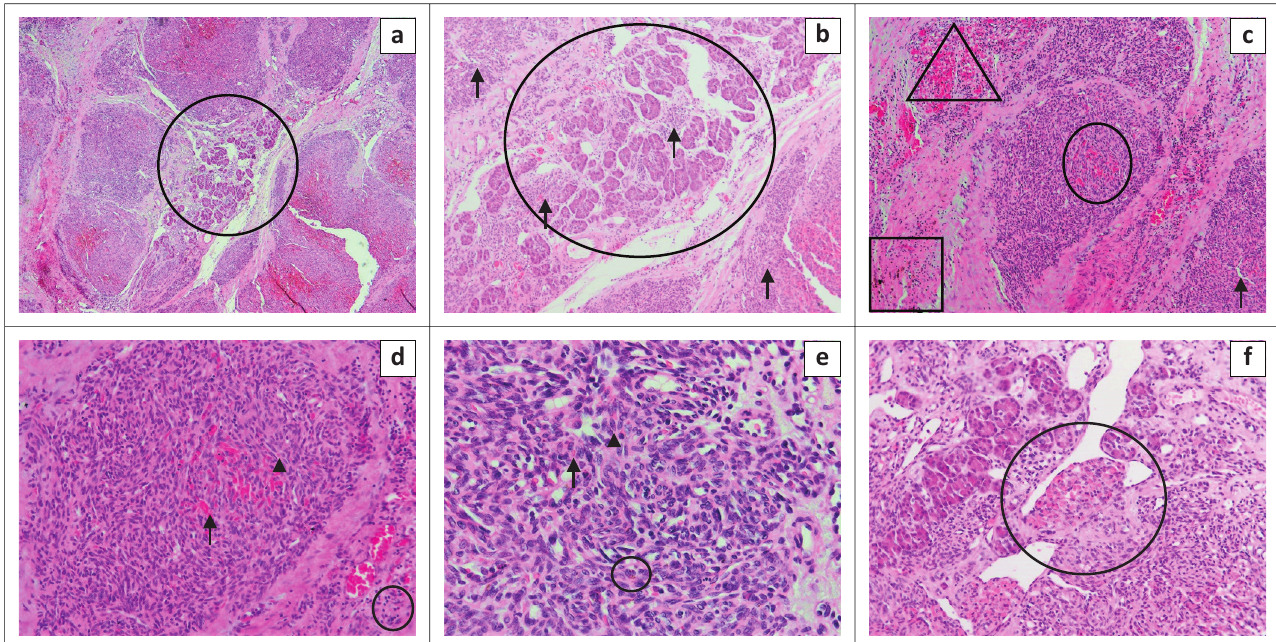
FIGURE 6: Photon microscopy of the pancreatic histology specimen with different magnification: (a) this low power image shows residual pancreatic tissue (centre circle) with surrounding lobules of the neoplastic infiltrate (4 × 10 magnification); (b) This higher power view of the same area (a) shows pancreatic acina, with surrounding and intermingled lobules of the neoplastic infiltrate (arrows) (10×10 magnification); (c) The neoplasm comprises spindled cells in swirling nodules. Slit-like vascular spaces are present (arrow). Extravasated red blood cells (oval) and hyaline globules (triangle) can be seen. Haemosiderin pigment is noted (square) (10×10 magnification); (d) This higher power view of the same area (c) better demonstrates the extravasated red blood cells (arrow) and hyaline globules (arrow head). Occasional inflammatory cells are visible (circle) (20×10 magnification); (e) This high-power image shows the spindle cell detail (40×10 magnification). The nuclei are elongated and bland with little pleomorphism and pale cytoplasm, with indistinguishable cell borders (arrow head). Haemosiderin pigment is evident (circle) and occasional extravasated red blood cells are present (arrow); (f) This image shows pancreatic acina and adjacent tumour. In the centre is a nodule of tumour bulging into a vessel, the so-called ‘promontory sign’ (circle) (20×10